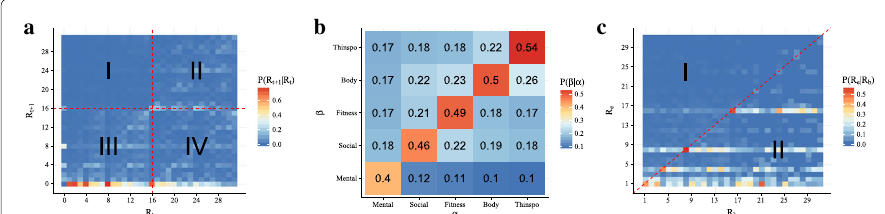
Fig. 4 Transitions of engagement in different topics. a Transition probabilities of topic engagement between two subsequent observations R t and R t + 1 ; b Fractions of users who posted content on topic α earlier will (cid:10) (β | α) is not necessarily equal to 1 as a user can post multiple different topics β post β later (note that β P after posting α ); c Transition probabilities of topic engagement between the beginning R b and the end R e of